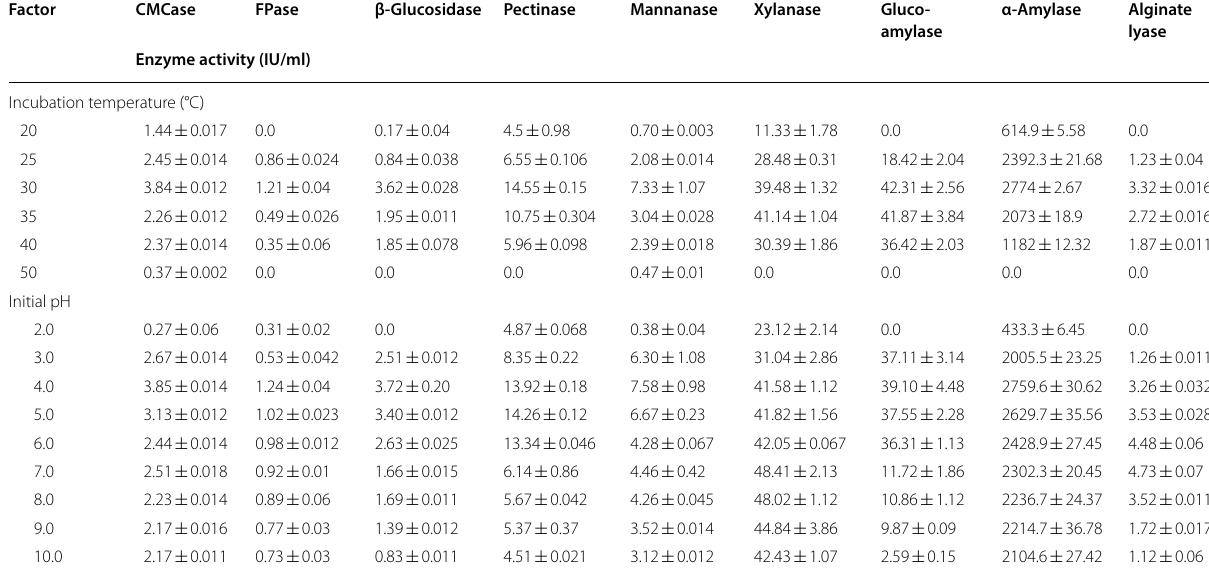
Table 2 Effect of environmental factors on co-production of various enzymes by A. niger APS